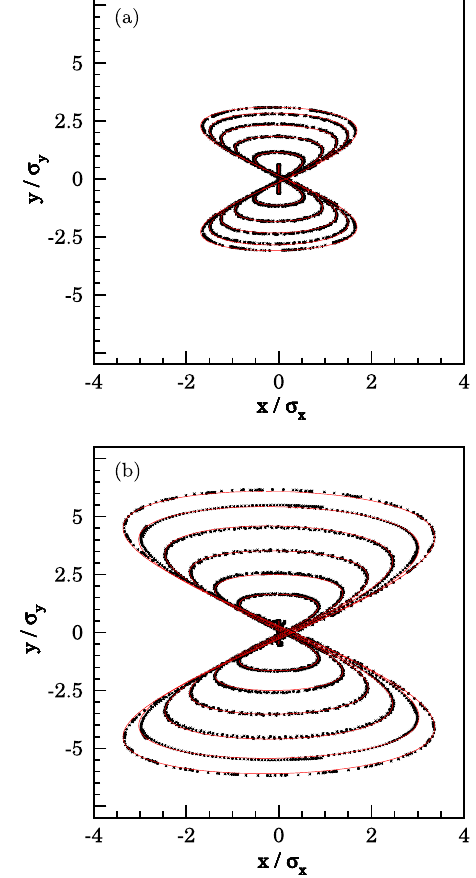
FIG. 17. (a) Sequence of fixed-lines constructed by a particle moving from z ¼ − 2 σ z to z ¼ 0 . (b) Same as in (a) but with the natural chromaticity included in the simulation. In both cases the red curves are obtained from Eq. (4) with one value of α